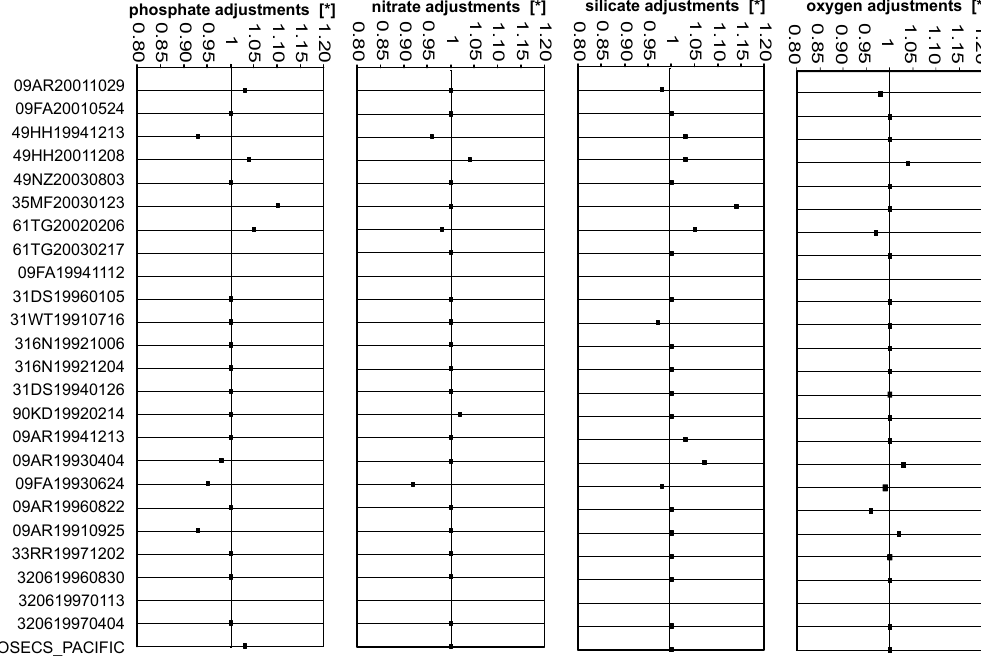
Figure 6. Multiplicative adjustments made to nutrient and oxygen data.